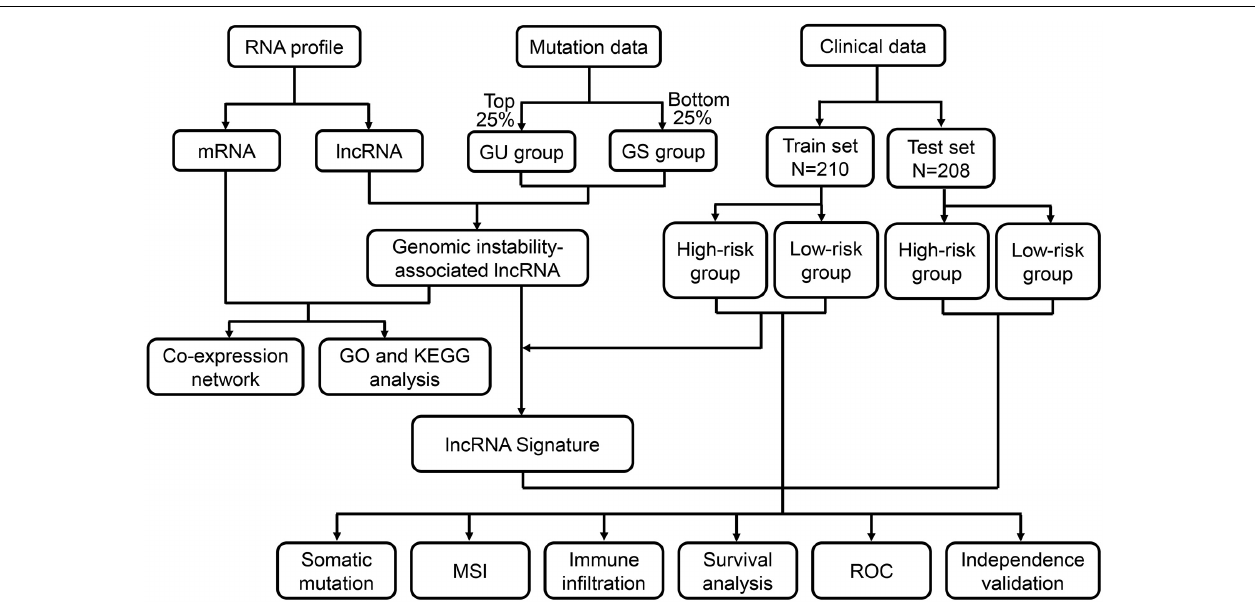
FIGURE 1 | Flow chart of the procedure applied in this study. The RNA profiles, mutation counts and clinical characteristics of colon cancer patients were downloaded from the TCGA database. Genome instability-associated lncRNAs were obtained after the identification of the differentially expressed lncRNAs between the two groups of patients with the top 25% and bottom 25% mutation count frequencies. After identifying the correlated mRNAs, a mRNA-lncRNA co-expression network was constructed, and functional enrichment analysis was performed. After combining the lncRNA data and the overall survival data, a lncRNA signature was developed for clinical outcome prediction. According to the calculated risk score, patients in the training set and testing set were classified into high- and low-risk groups. Correlation of risk score, somatic mutation, microsatellite instability (MSI) and immune infiltration was analyzed. The prognostic prediction efficiency was verified through survival analysis, receiver operating characteristic (ROC) curves and independent validation. GU, genome unstable; GS, genome stable; TCGA, The Cancer Genome Atlas; GO, Gene Ontology; KEGG, Kyoto Encyclopedia of Genes and Genomes.